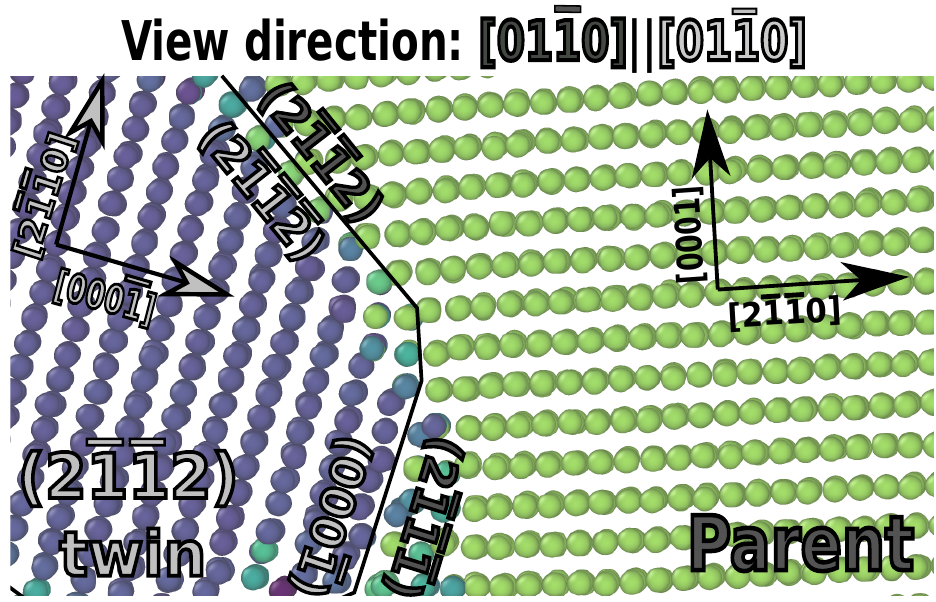
Figure 3. Facet between the ( 2111 ) plane of the parent and the ( 0001 ) plane of the twin. The ( 2112 ) twin plane interface is also visible in the upper portion of the